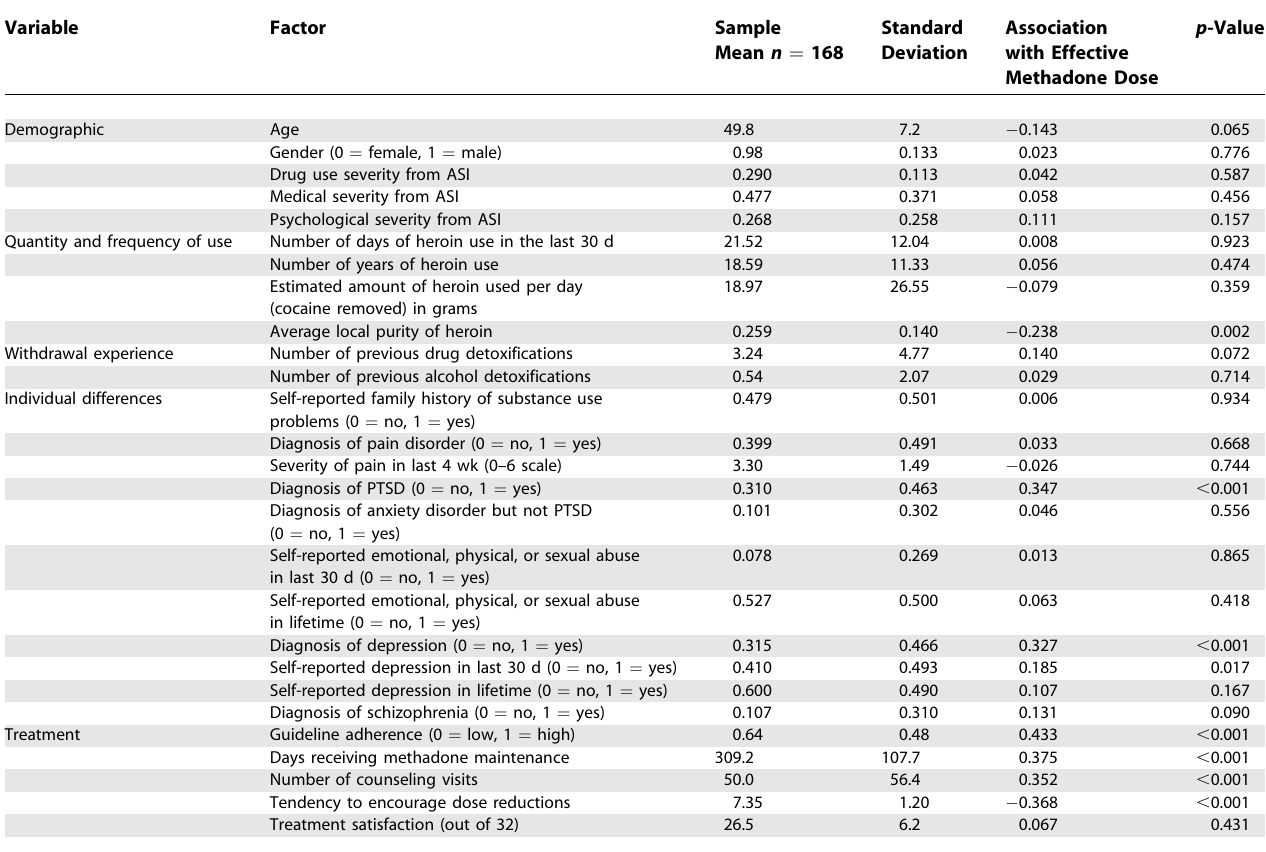
Table 1. Associations between Potential Opioid Tolerance-Related Factors and the Methadone Dose at Which Patients Achieved Heroin